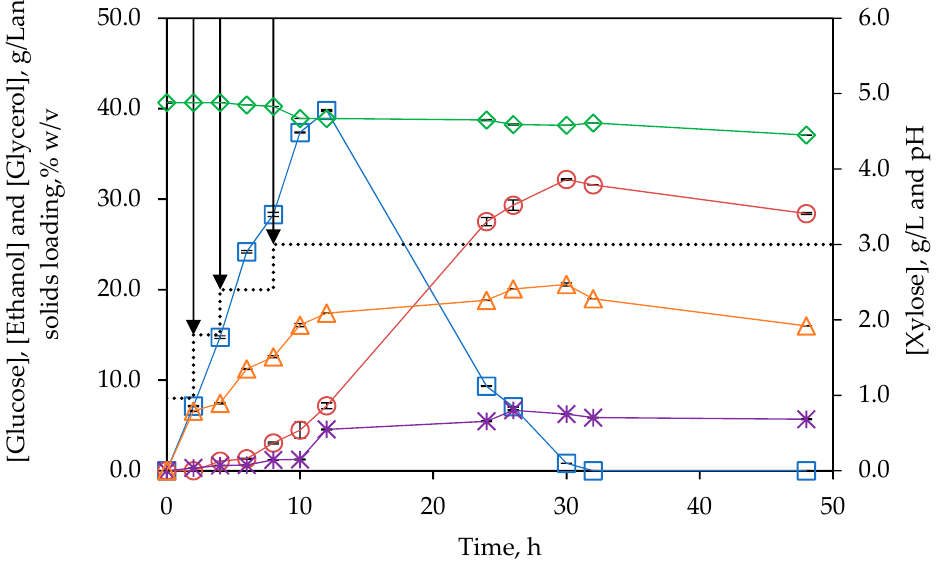
Figure 7. Evolution of ◇ pH and □ glucose, △ xylose, ○ ethanol and ∗ glycerol concentrations for fermentation from subW-pretreated BSG at a total solids’ loading of 25% ( w/v ) following a fed-batch SSF configuration. The discontinuous line shows solids’ charges over time. Analytical measure- ments were conducted in triplicate.